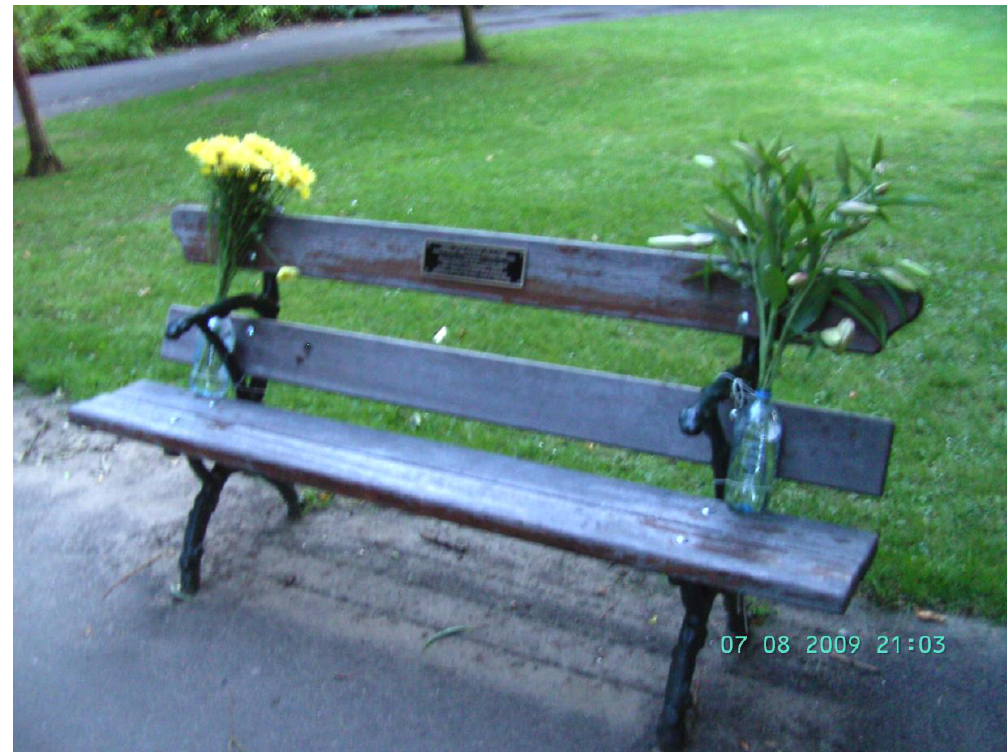
Figure 7. A memorial